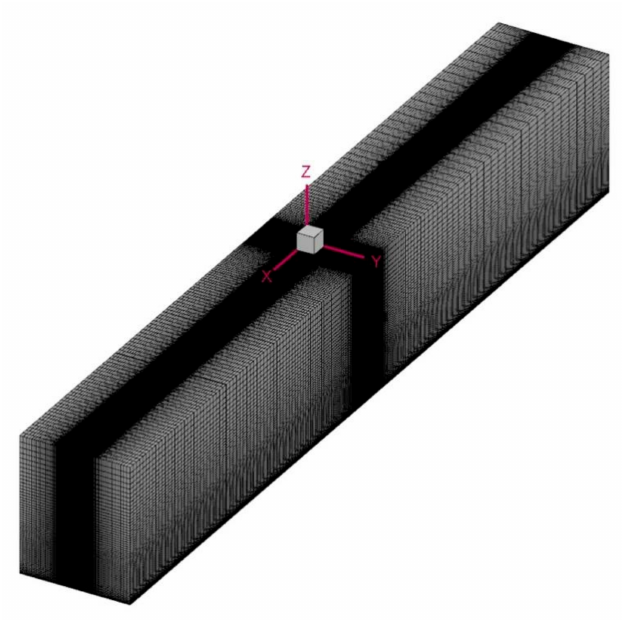
Figure 2. Calculation area and mesh used in the